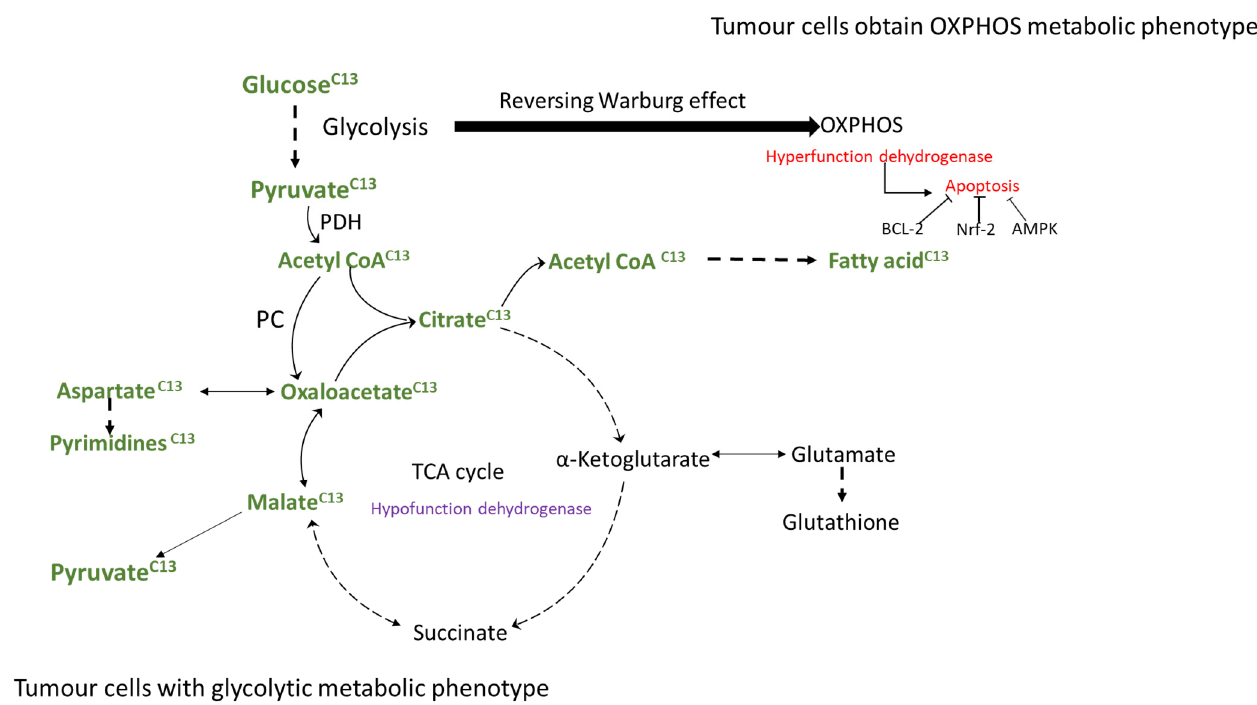
Figure 2. Tumour cells with glycolytic phenotype have high mitochondrial oxidative metabolism and can switch to OXPHOS. Glycolytic tumour cells absorb glucose (C13 labelled) and produce pyruvate. Pyruvate can be catalysed by PC and PDH for producing carbon-derived metabolites (such as citrate and oxaloacetate). Tumour cells that perform this process are “hypofunctive on dehydrogenase”. The TCA cycle in this process can be used for biosynthesis (such as synthesizing fatty acid, pyrimidines, and pyruvate). Switching from glycolysis to OXPHOS can cause a reverse Warburg Effect and change the phenotype of tumour metabolism. The hyperfunction successful dehydrogenase activated by OXPHOS function can generate more oxidative stress, causing cell death, which is not beneficial for the long-term survival of tumour cells. Tumour cells can then counter the endogenous damage caused by increasing the anti-apoptotic proteins such as B-cell lymphoma-2 (BCL-2), nuclear factor erythroid 2-related factor 2(Nrf-2), and 5 ′ -AMP-activated protein kinase (AMPK). Tumour cells that perform this process are “hyperfunctive on dehydrogenase.”